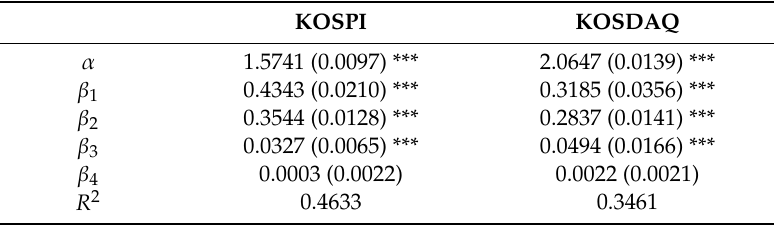
Table 5. Estimates of herding behavior in high- and low-volatility